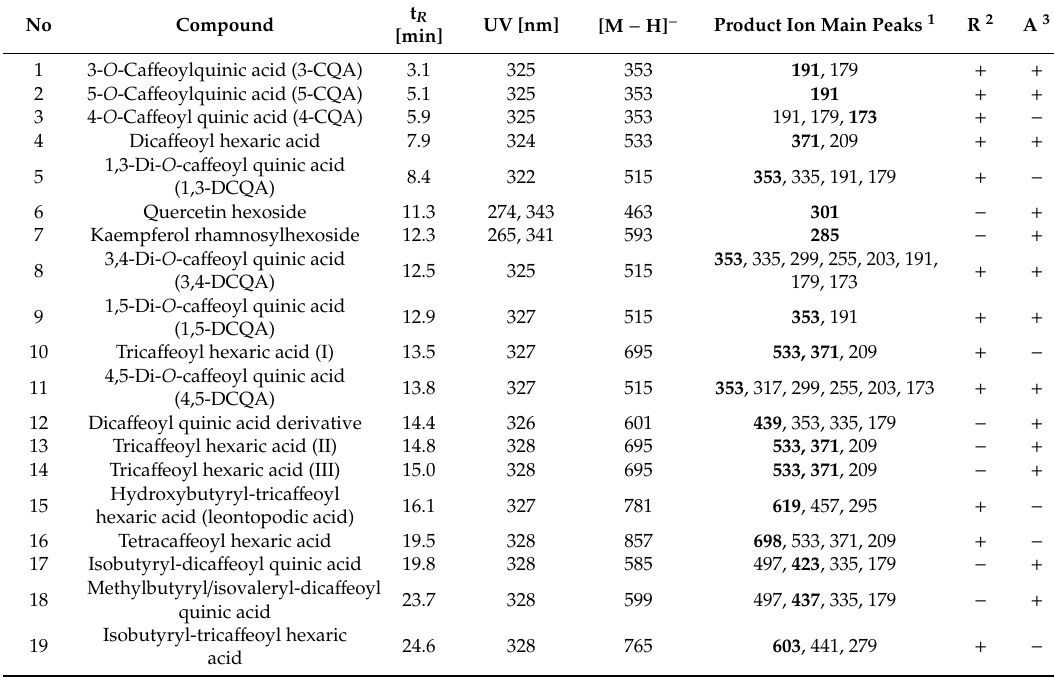
Table 1. Retention times, UV maxima and MS n data, in the negative ion mode, for the phenolic compounds present in extracts from Xerolekia speciosissima roots and aerial parts.